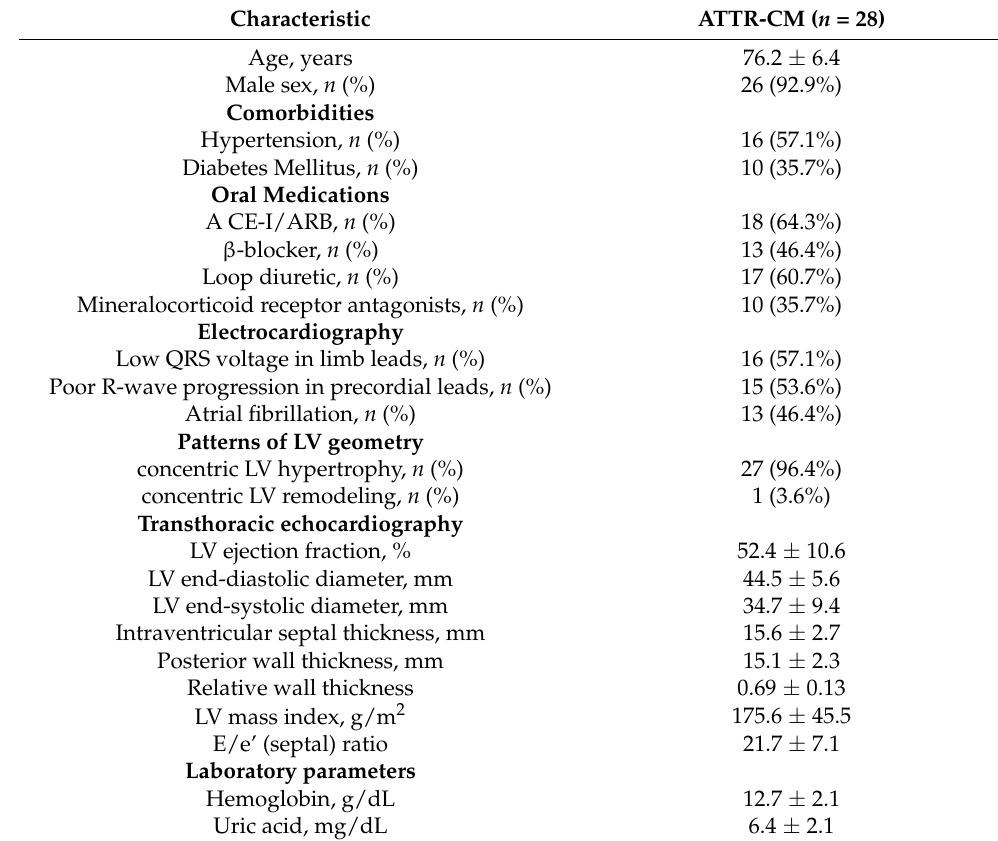
Table 1. Baseline clinical characteristics of the patients with